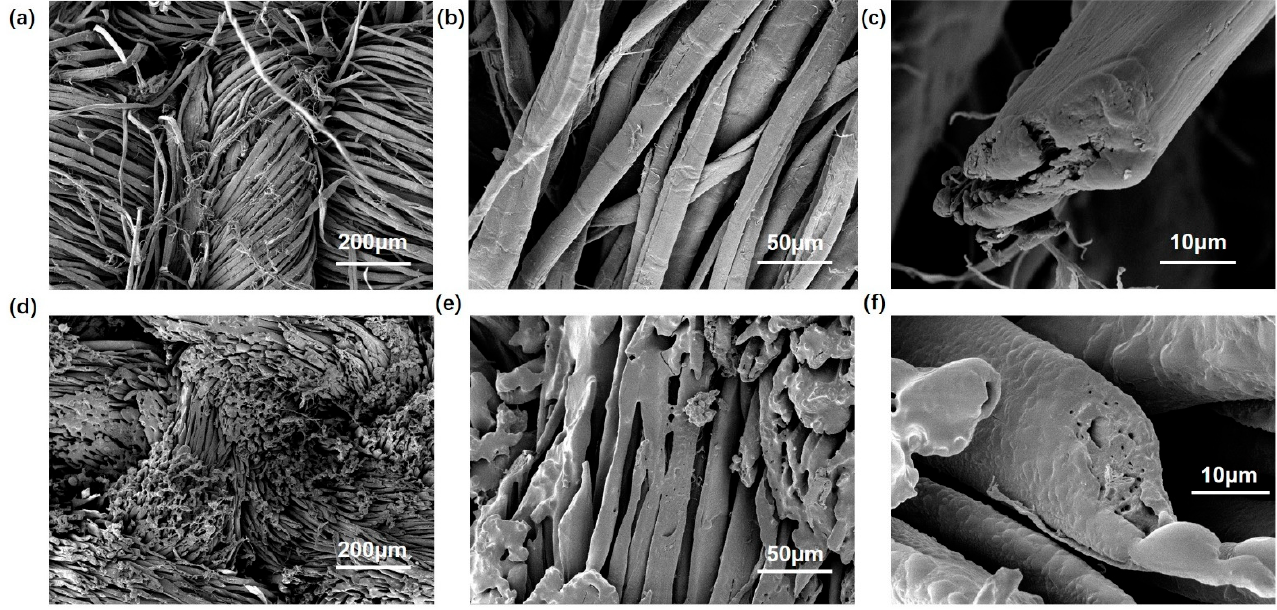
Figure 4. ( a – c ) SEM images of carbonized pristine ramie fabric. ( d – f ) SEM images of